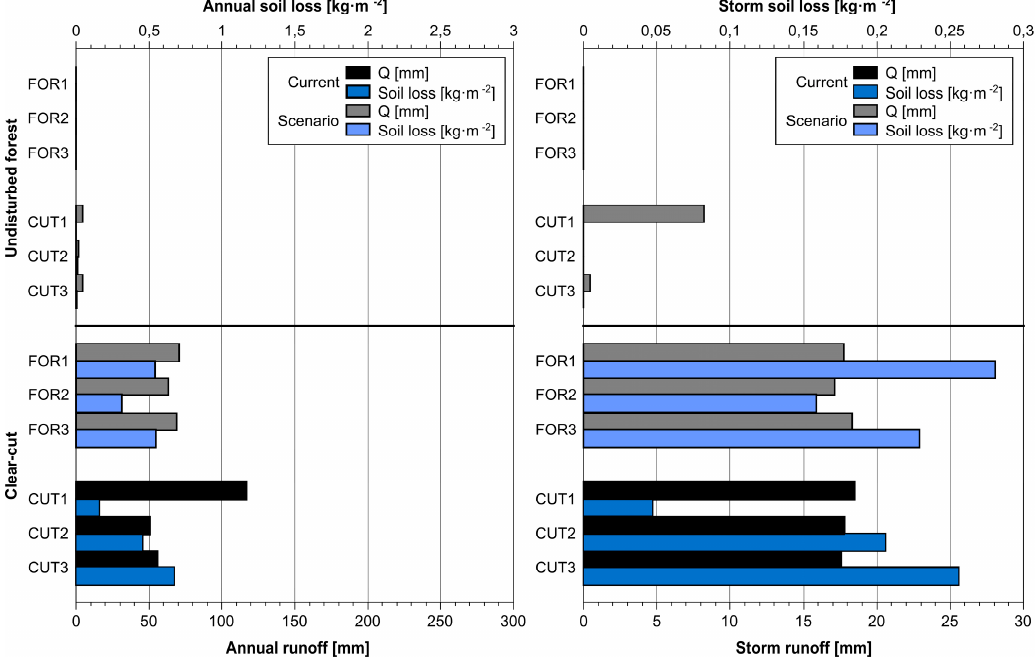
Table 18. Mean modeled storm runoff and soil loss. Bold values represent current land use.